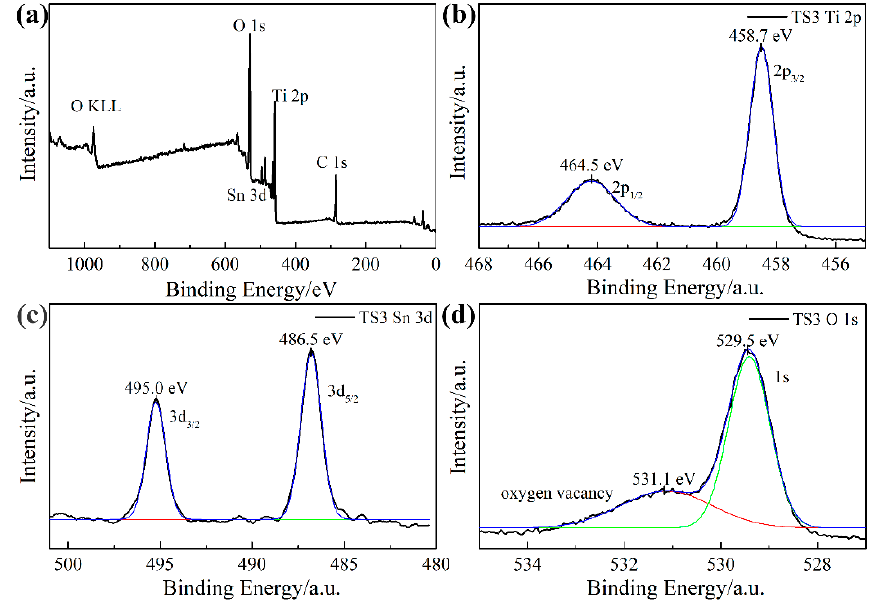
Figure 3. ( a ) X-ray photoelectron spectroscopy (XPS) patterns of Sn-doped TiO 2 NWAs (TS2), ( b ) Ti 2p peaks, ( c ) Sn 3d peaks, ( d ) O 1s